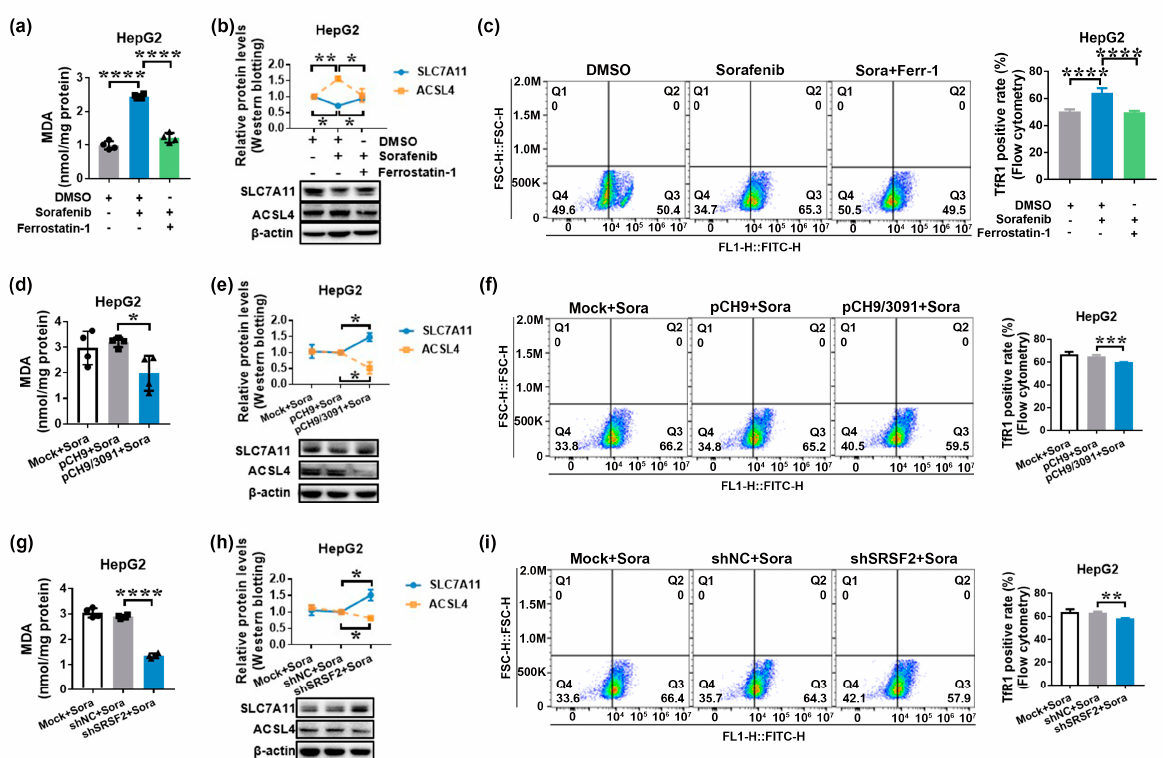
Figure 4. HBV and shSRSF2 prevent sorafenib-induced ferroptosis. HepG2 cells were treated for 24 h with 30 μ mol/L of sorafenib with or without 10 μ mol/L of ferrostatin-1. The MDA levels and expression of SLC7A11, ACSL4, and TfR1 were then determined in order to identify the involvement of sorafenib in ferroptosis in HepG2 cells ( a – c ). The MDA levels were determined using an MDA detection kit. The graph shows the MDA levels in HepG2 cells. **** p < 0.0001 ( a ). Western blotting was used to assess the expression of SLC7A11 and ACSL4. The line graph depicts the levels of SLC7A11 and ACSL4 expression in HepG2 cells. * p < 0.05, ** p < 0.005 ( b ). Flow cytometry was used to detect TfR1-positive cells. The graph displays the TfR1-positive rate. **** p < 0.0001 ( c ). HepG2 cells were transiently transfected with pCH9 or pCH9/3091 plasmids for 24 h before being treated for additional 24 h with 30 μ mol/L of sorafenib. The MDA levels and expression of SLC7A11, ACSL4, and TfR1 were then measured to determine the role of HBV in sorafenib-induced ferroptosis in HepG2 cells ( d – f ). The MDA levels were determined using an MDA detection kit. The graph shows the MDA contents. * p < 0.05 ( d ). The SLC7A11 and ACSL4 expressions were measured by Western blotting. The line graph shows the relative expression levels of the proteins mentioned. * p < 0.05 ( e ). The TfR1-positive cells were detected using flow cytometry. The graph shows the TfR1-positive rate. *** p < 0.005 ( f ). HepG2 cells were transiently transfected with shNC or shSRSF2 plasmids for 24 h before being treated for another 24 h with 30 μ mol/L of sorafenib to assess the relevance of SRSF2 in sorafenib-induced ferroptosis in HepG2 cells ( g – i ). An MDA detection kit was used to determine the MDA levels. The graph represents the MDA content. **** p < 0.0001 ( g ). Western blotting was used to assess the expression of SLC7A11 and ACSL4. The line graph illustrates the relative levels of expression of the indicated proteins. * p < 0.05 ( h ). The TfR1-positive cells were identified using flow cytometry. The graph shows the TfR1-positive rate. ** p < 0.005 ( i ). The graphs depict the mean ± SD of at least three different experiments.